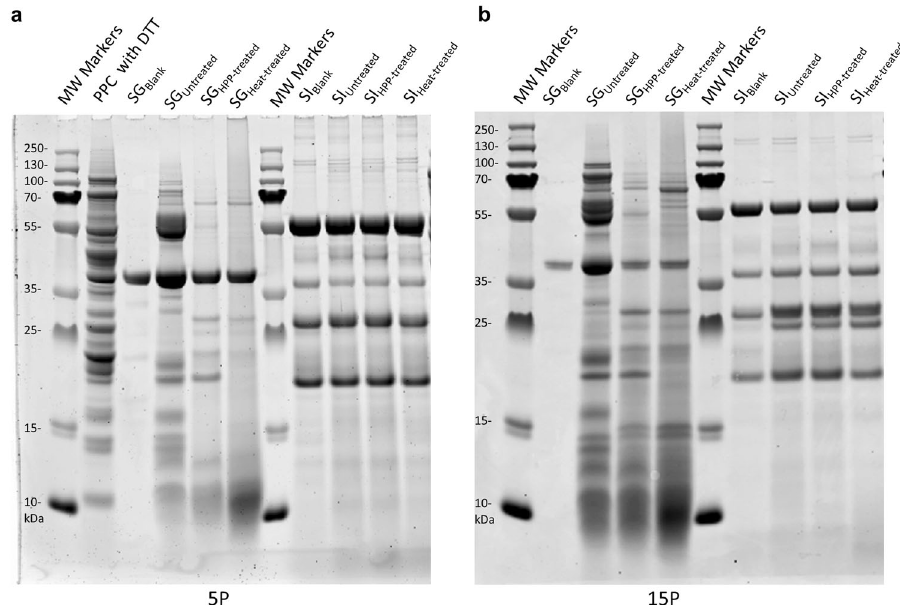
Fig. 1 SDS-PAGE of un fi ltered static model digesta. Representative gels of a untreated undigested pea protein concentrate (PPC) and un fi ltered SG and SI after static in vitro digestion of PPC with 5% (w/w) protein (5 P) and b un fi ltered SG and SI after static in vitro digestion of PPC with 15% (w/w) protein (15 P). SG was the static model cumulative gastric digesta and SI was the static model cumulative intestinal digesta, see Table 1 for all symbol descriptions. Gels were run for each independent replicate of digestions in technical duplicate. DTT was added to the untreated undigested PPC to distinguish subunits. Molecular weight markers were included for reference. The major protein bands for PPC were at 71 kDa for convicilin subunits; 50, 30 – 35, and 13 – 20 kDa for vicilin subunits; 40 and 20 kDa for legumin subunits; and 25 – 26, 4, and 6 kDa for albumin polypeptides 29 . Blank digestions consisting of water in replace of PPC were conducted to discriminate enzymes from PPC. Pepsin was localized around 35 kDa on the gels, whereas pancreatic lipases, amylases, and proteases were around 20 – 25 and 40 – 55 kDa 30 self-standing gel structures. Detailed information regarding the structure and rheological properties of these protein systems can be found in the studies by Sim et al. 4,5 .